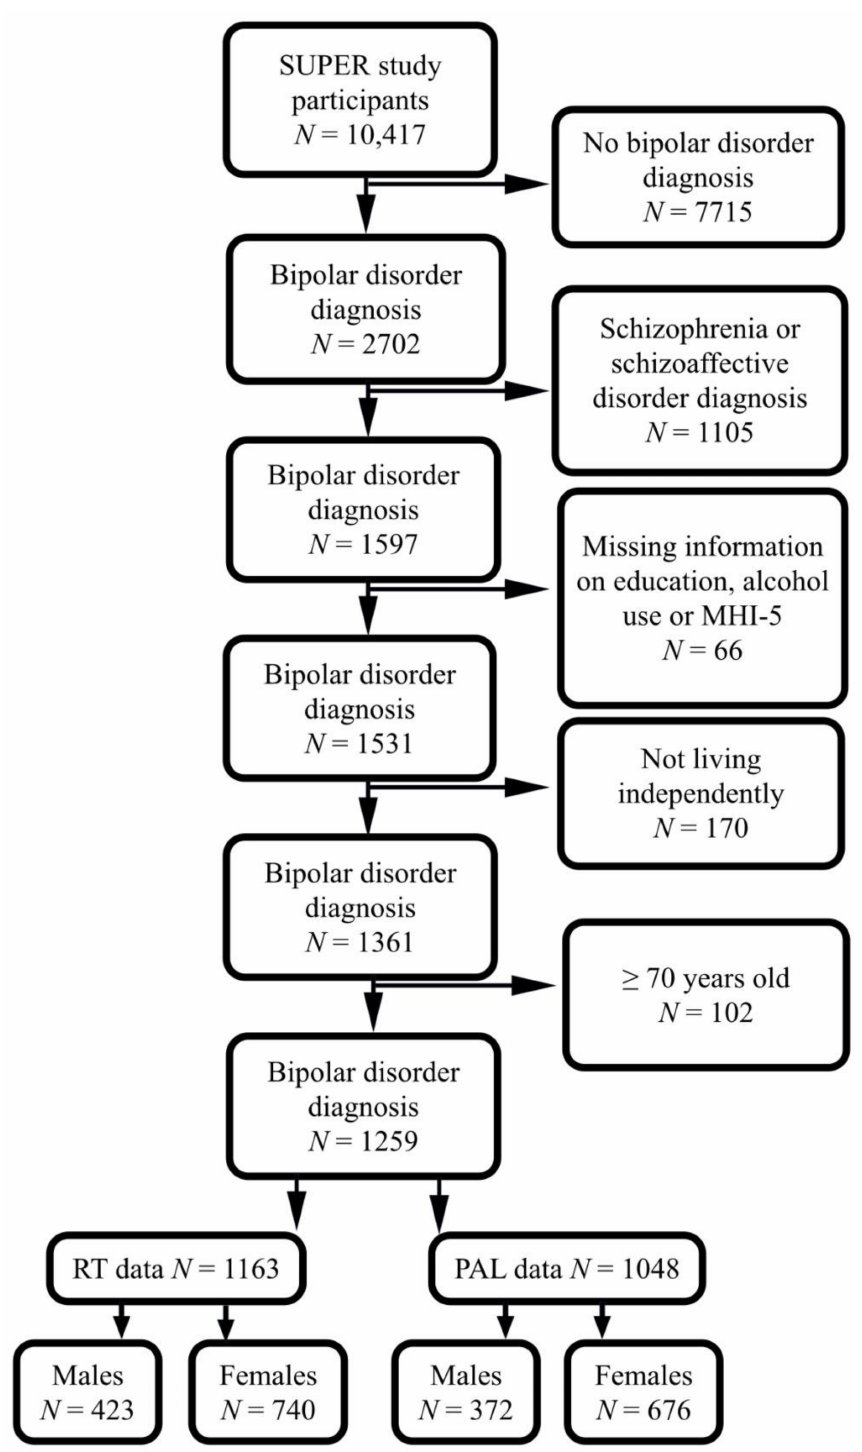
Figure 1. Flowchart showing the selected study population. SUPER, Suomalainen psykoosisairauk- sien perinnöllisyysmekanismien tutkimus; MHI-5, mental health inventory-5; RT, reaction time; PAL, paired associative